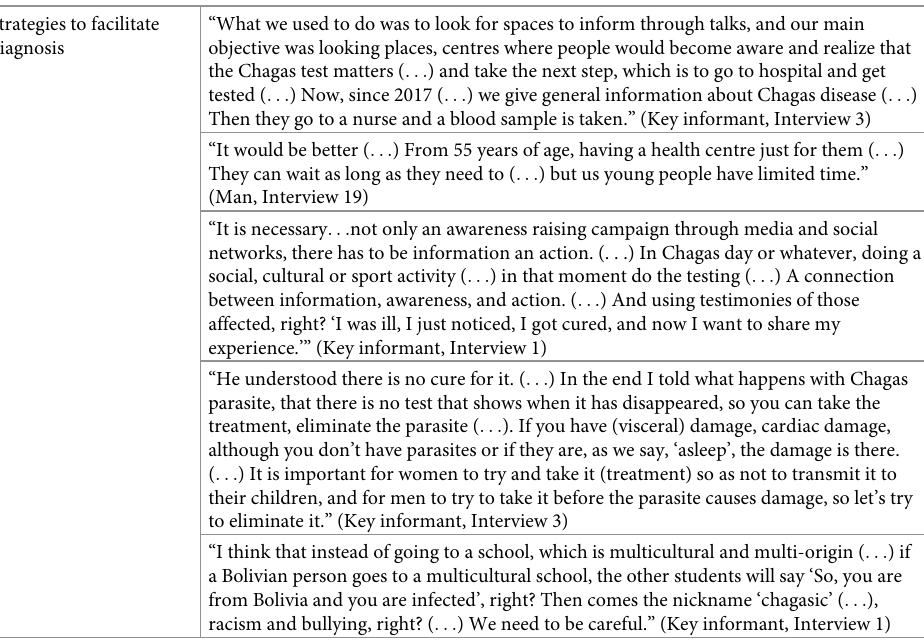
Table 10. Quotes related to strategies to facilitate diagnosis. Strategies to facilitate